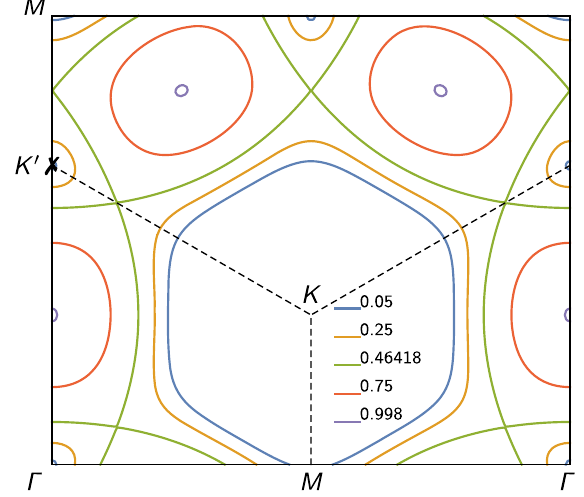
FIG. 9. Energy-conserving decay contours in reciprocal space for an initial Dirac magnon at the K 0 point (see ✗ symbol) with energy ε . Colored lines correspond to selected values of D magnetic field B= ð JS Þ as indicated. At small fields (blue and orange lines), there are three contours, respectively centered around the Γ , K 0 , and K points. At large fields (red and purple lines), the decay contours are centered about the midpoints of the lines from Γ to K 0 . At a critical field, there is a Lifshitz transition of the decay contours from the low-field to the high-field case, as indicated by the green lines. This transition corresponds to a saddle point of the two-magnon continuum and, hence, a logarithmic singularity in the imaginary part of the